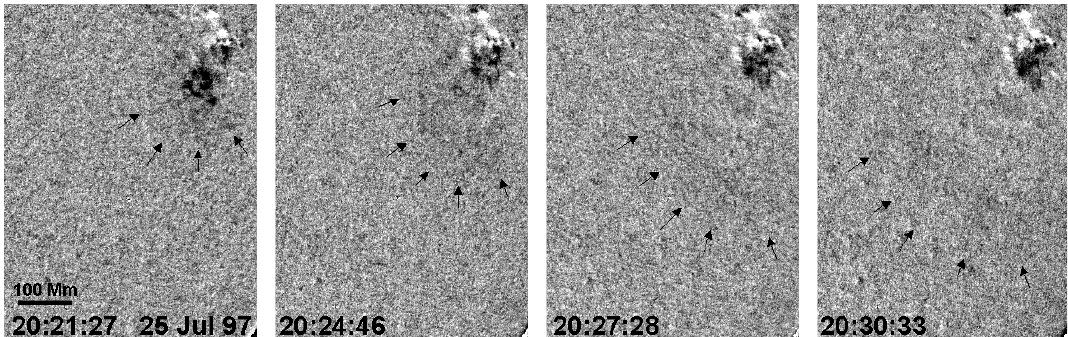
Figure 11: The He i wave of 1997 Jul 25. Shown are difference images from which a pre-event frame has been subtracted. The He i wave is seen as an expanding diffuse dark front (its leading edge is indicated by black arrows). The bright patches in the upper right corner are due to the associated flare. Image reproduced with permission from Vrˇsnak et al. (2002b), copyright by